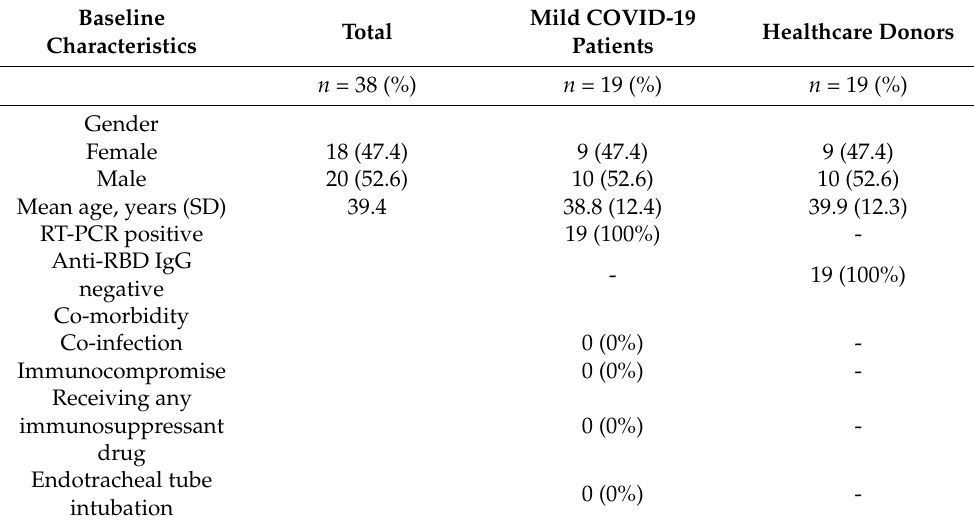
Table 1. Baseline characteristics of mild COVID-19 patients and healthcare donors. Mild COVID-19 patients ( n = 19) who were recruited and consented to this research were matched by sex and age with healthcare donors ( n = 19). All patients were confirmed by positive RT-PCR results. No co-infection, immunocompromised status, immunosuppressant treatment, or endotracheal tube intubation were shown in any participants, as per the exclusion criteria. The controls were healthcare donors who had not been vaccinated or infected with SARS-CoV-2. All of the controls were seronegative for the anti-RBD IgG of SARS-CoV-2. Mild COVID-19 Baseline Healthcare Total Patients Characteristics